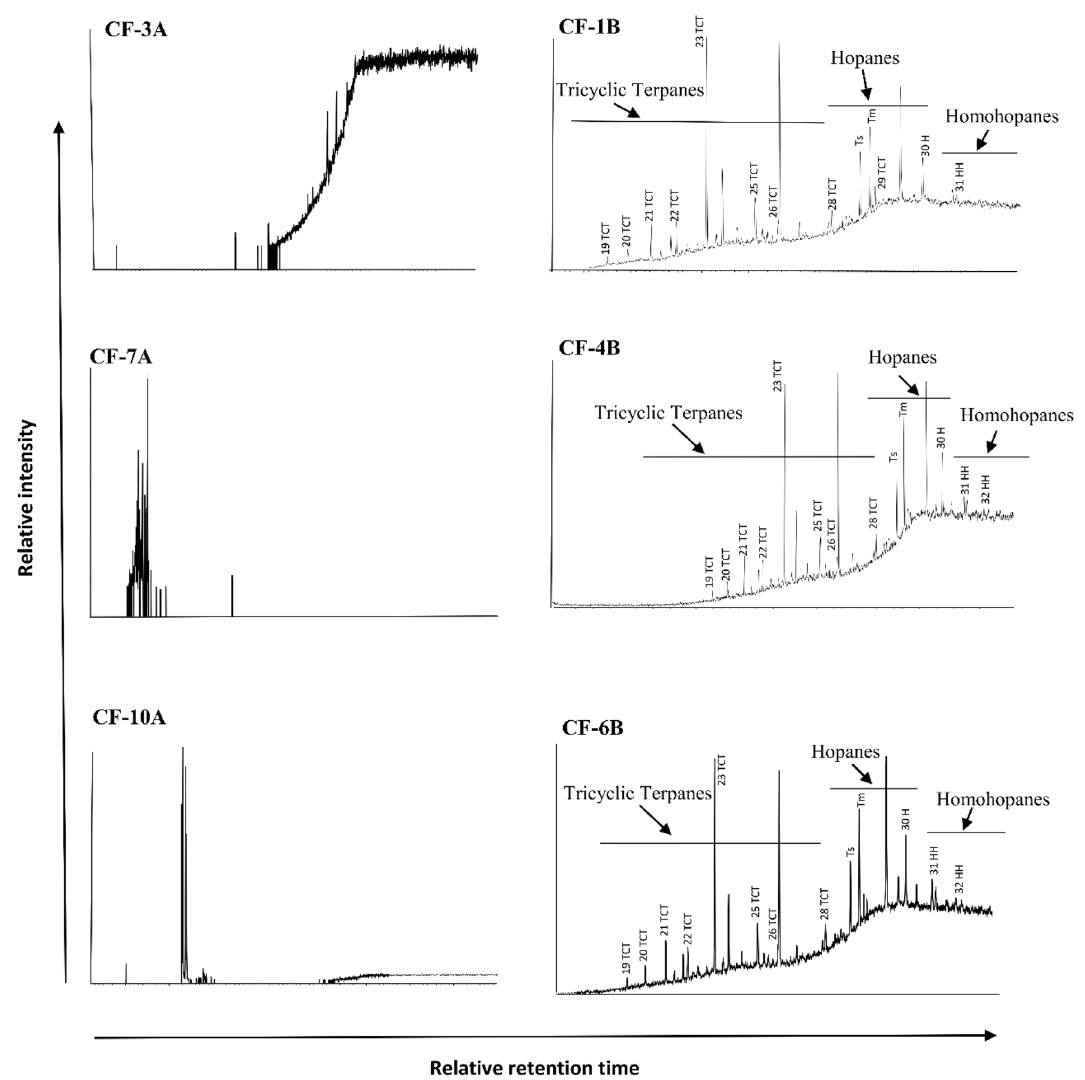
Fig. 9 m/z 191 chromatograms of Mela-05 drill cuttings (left) and outcrop samples (right) showing distribution of TCT and hopanes